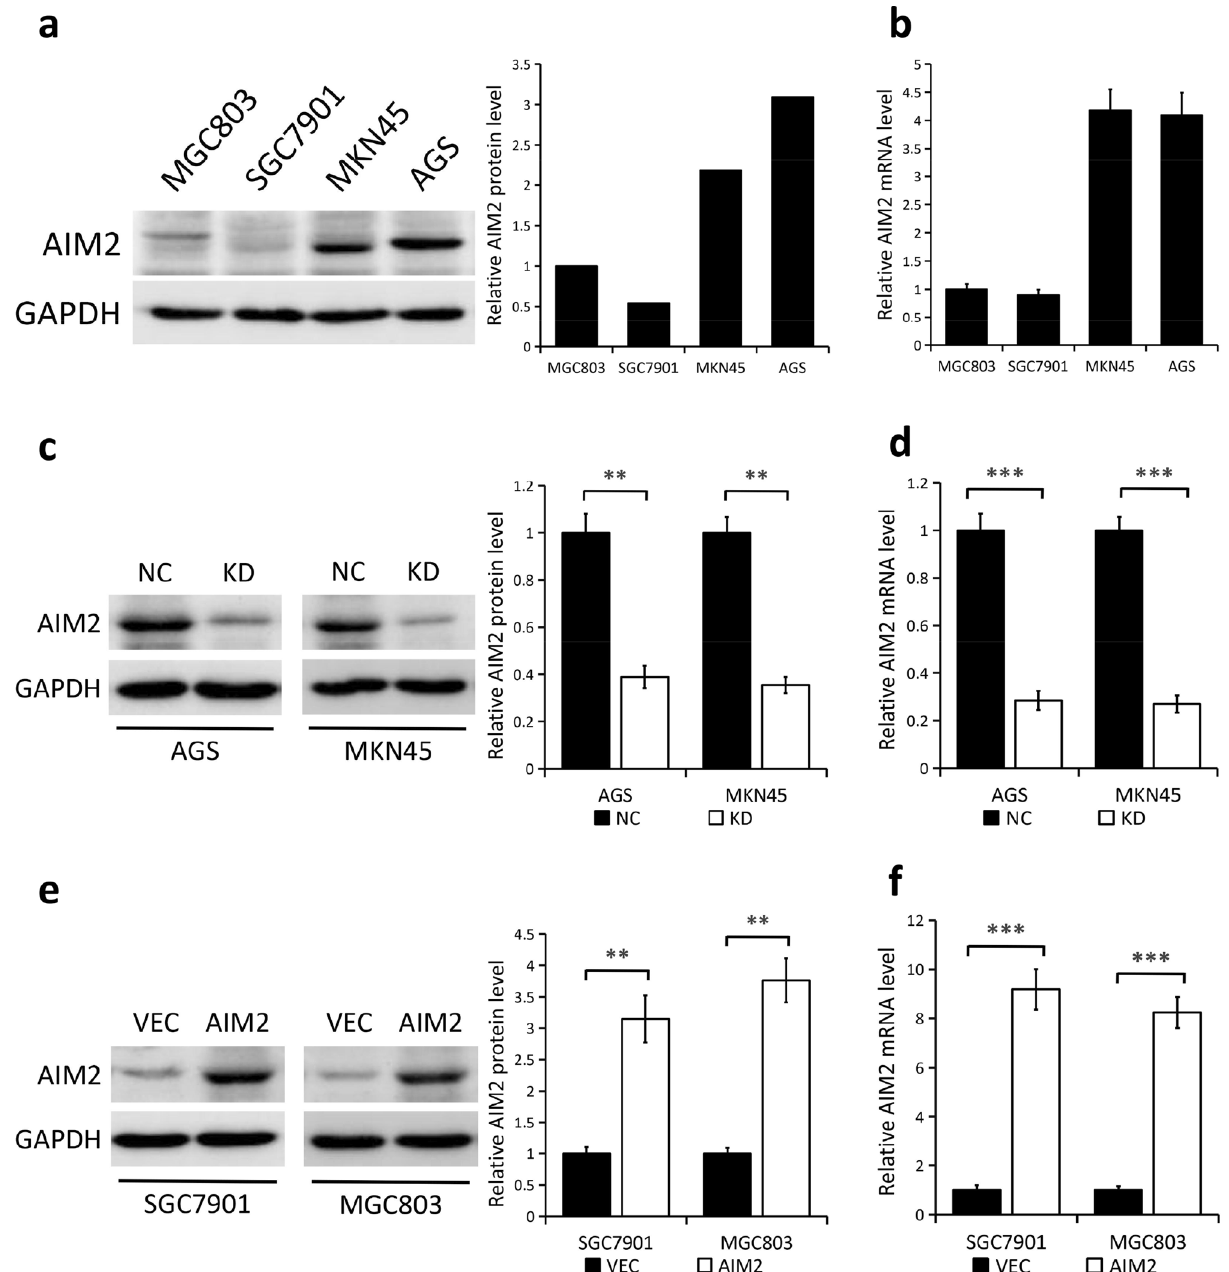
Figure 2. Knockdown and overexpression efficiency of AIM2 in GC cell lines. ( a , b ) The protein ( a ) and mRNA ( b ) expression of AIM2 in four human GC cell lines (MGC803, SGC7901, MKN45 and AGS). ( c , d ) The protein ( c ) and mRNA ( d ) expression of AIM2 in wild-type AGS and MKN45 cells (NC) and in cells with stable knockdown of AIM2 (KD). ( e , f) The protein ( e ) and mRNA ( f ) expression of AIM2 in wild-type SGC7901 and MGC803 cells (VEC) and in cells with stable overexpression of AIM2 (OE). GAPDH as a loading control. The proteins were quantified using the ImageJ software (version: 1.4.3). ** P < 0.01. *** P < 0.001. The original Western blots are included in the Supplementary Fig.